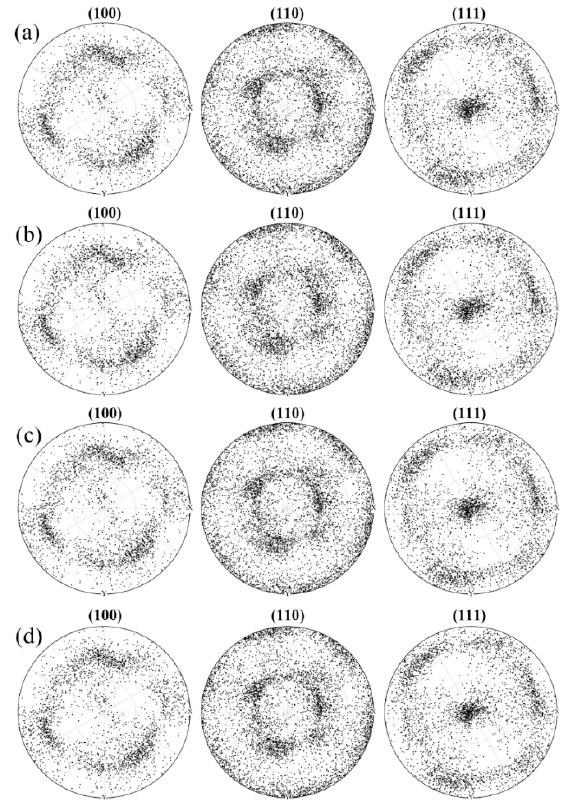
Figure 3. The simulated pole figures at the deformation degree of 30% in the case of various linearization schemes in the VPSC model: ( a ) Affine scheme; ( b ) Secant scheme; ( c ) Neff = 10 scheme; ( d ) Tangent scheme.